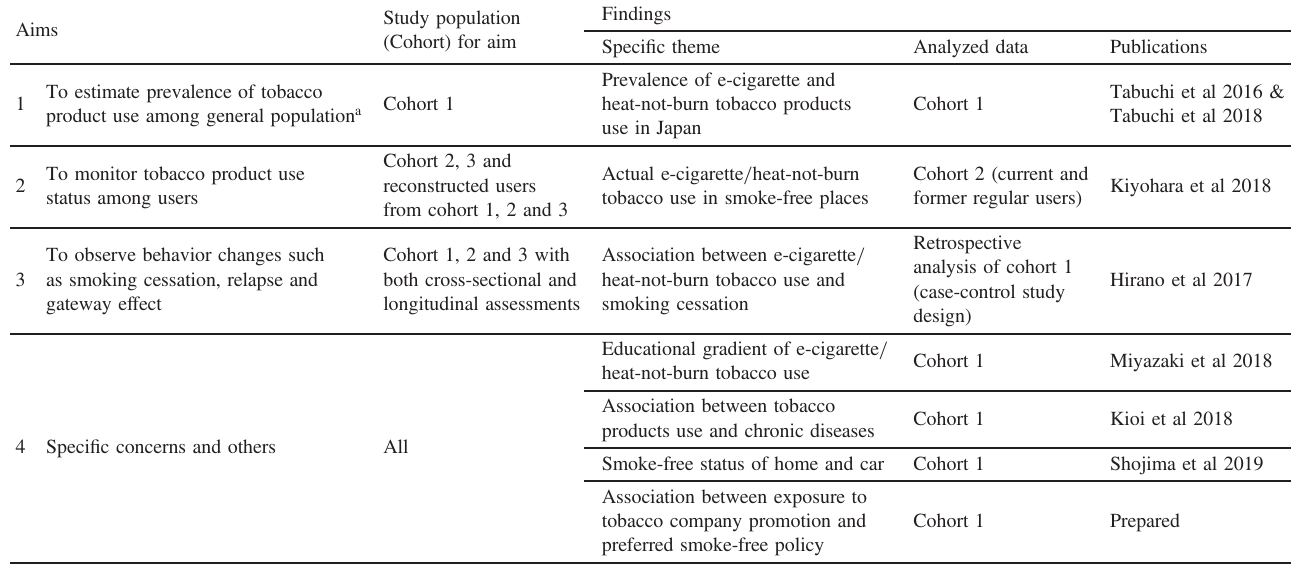
Table 1. Aims, study population and study examples in the JASTIS